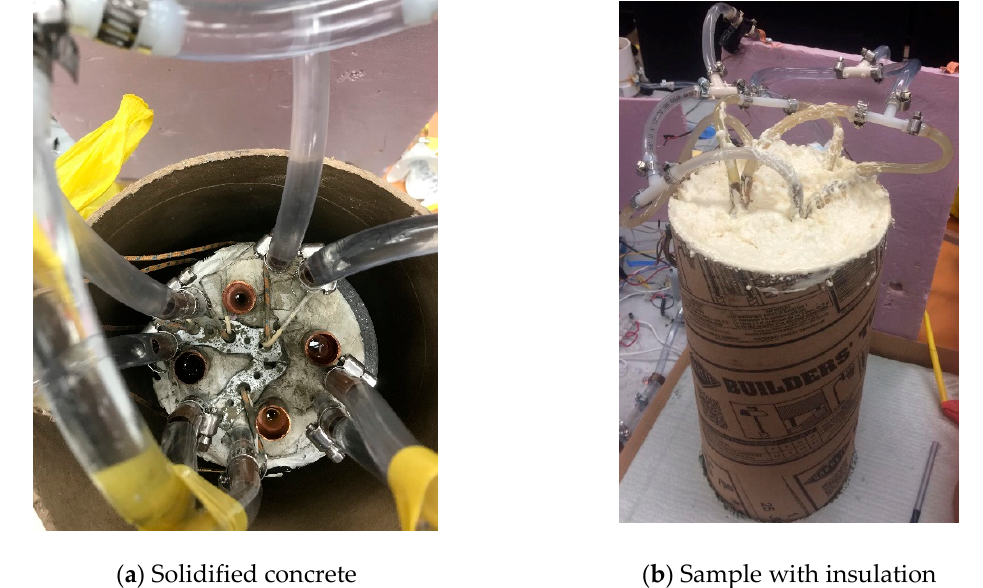
Figure 5. Concrete pouring and insulating processes.